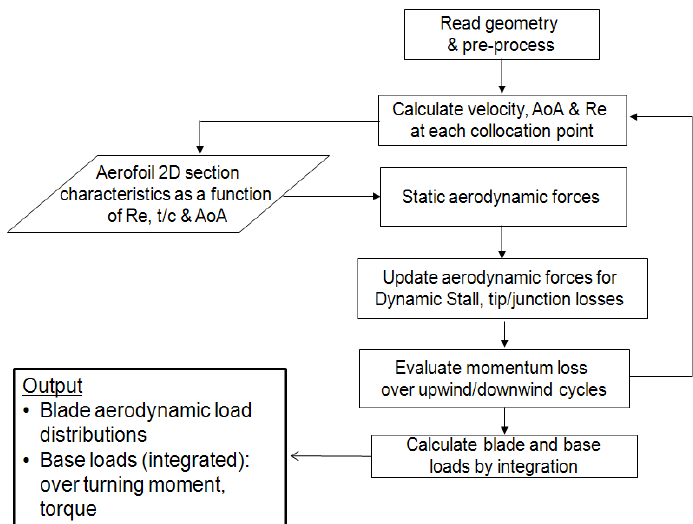
Figure 2. Schematic of the turbine model